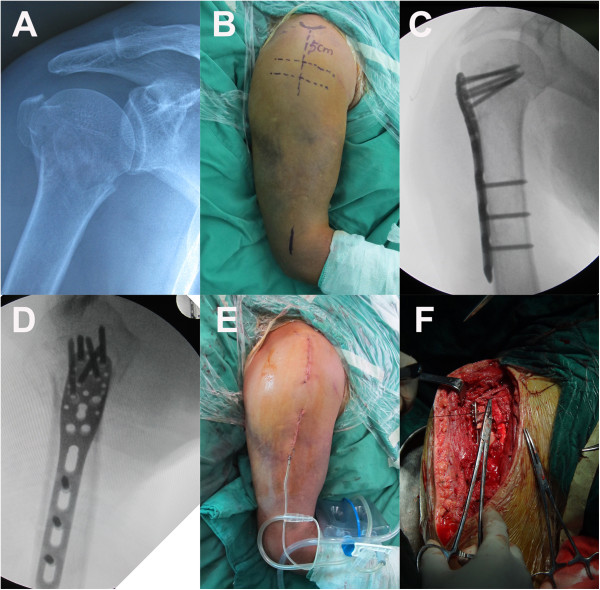
A, Preoperative radio-graph of a70-year-old man with a displaced 3-part fracture (AO 11-B1) of the humeral head. B, Two marker lines perpendicular to the palpable shaft of the humerus. The first line was5cm distal to the tip of the acromion and another line was2cm further distal to the first line. The area between these two lines was considered an unsafe zone. C and D, Postoperativeradiographshows proper placement of plate and screws. E, Theminimally invasive approach shows that two small incisions with a skin bridge over the palpated axillary nerve. F, Thedeltopectoral approachrequired an approximately 14cmin the ORIF group.